Question: Does the plotted quantity increase or decrease?
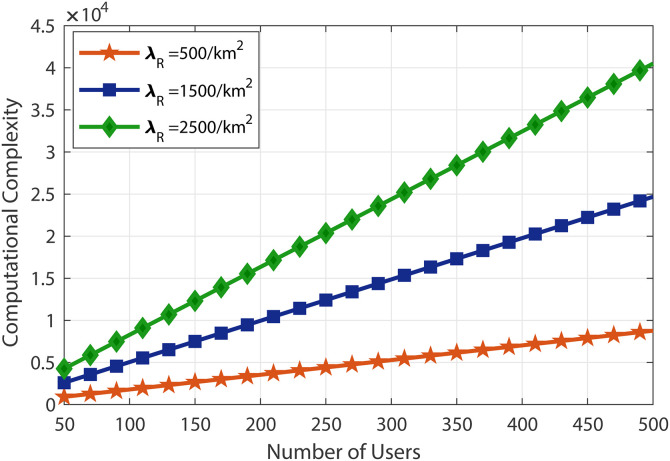
Answer: increasing